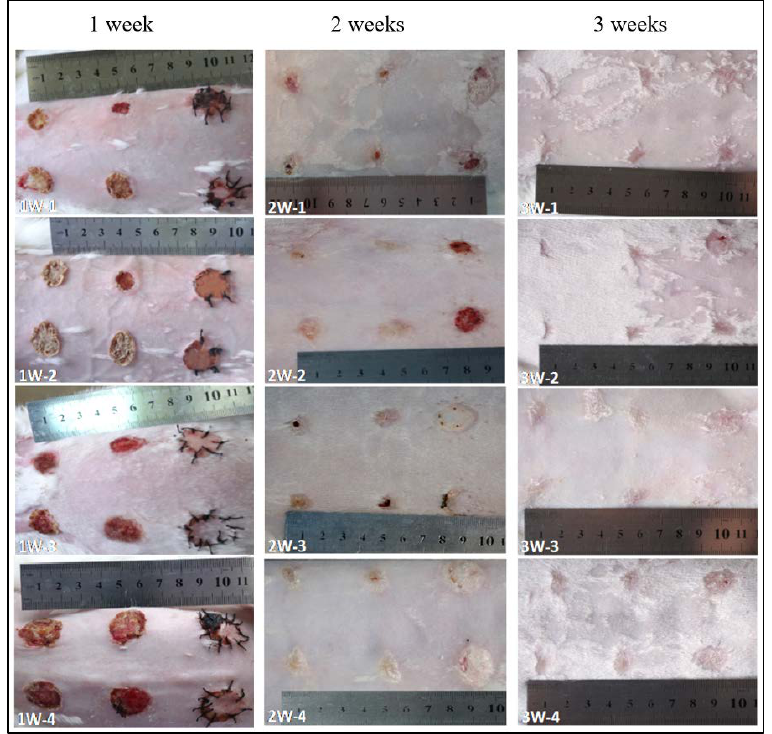
Figure 5. The photographs of skin wound repair at 1 week, 2 weeks, and 3 weeks.